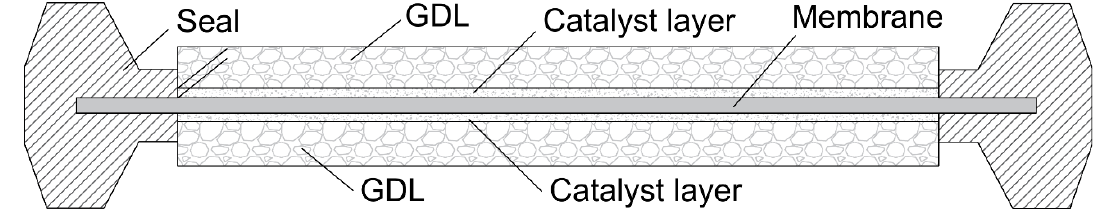
Figure 13. PEM-wrapped frame sealing